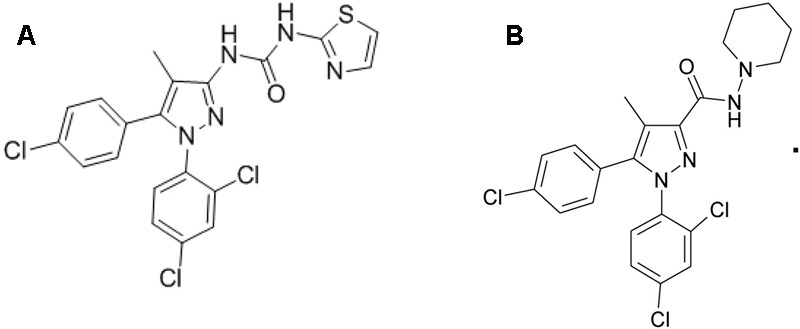
Chemical structures of (A) TXX-522 and (B) SR141716A.